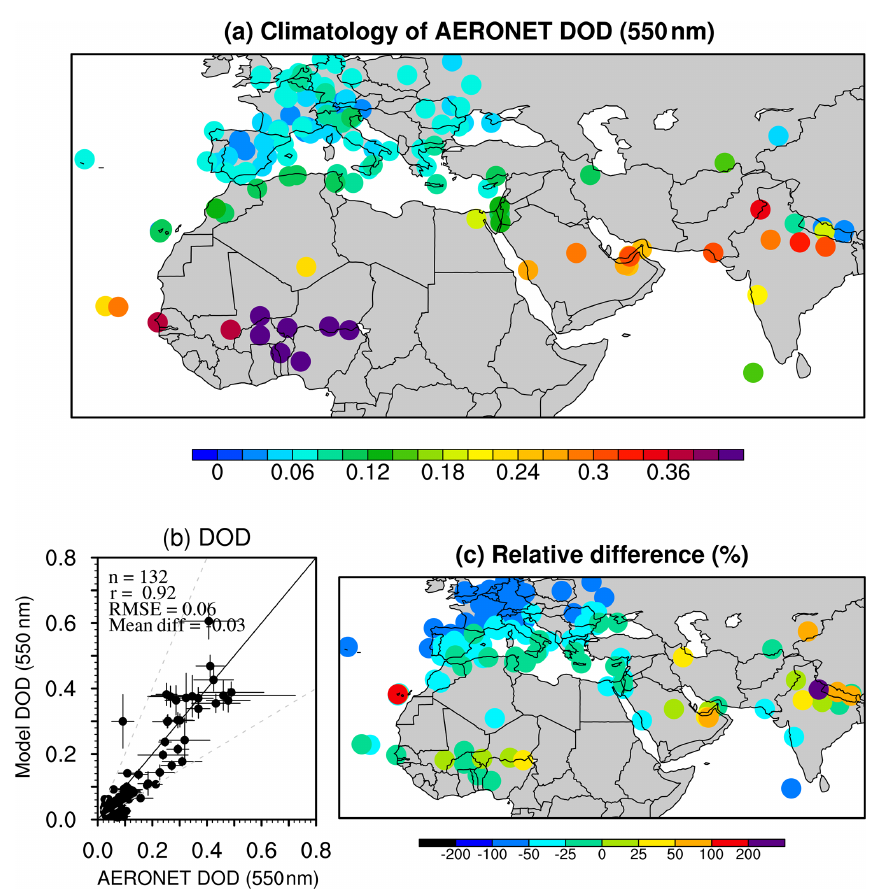
Figure 7. (a) Climatology (2003–2015) of AERONET DOD (550nm) over major dusty regions and (b) scatter plot of modeled DOD in the V thresh 12mn simulation versus AERONET DOD. (c) The relative difference (as a percentage) between modeled DOD and AERONET DOD in the V thresh 12mn